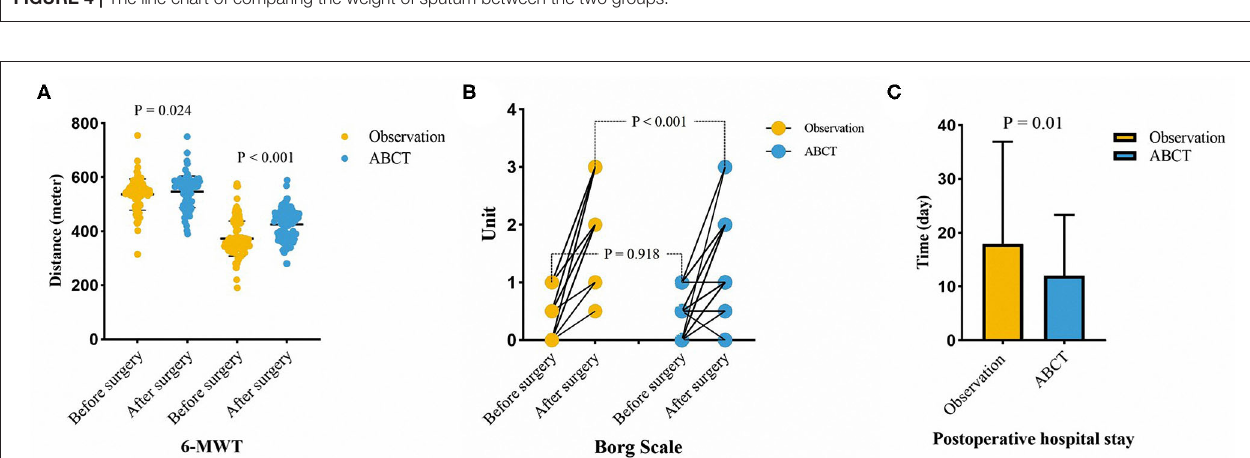
FIGURE 4 | The line chart of comparing the weight of sputum between the two groups.